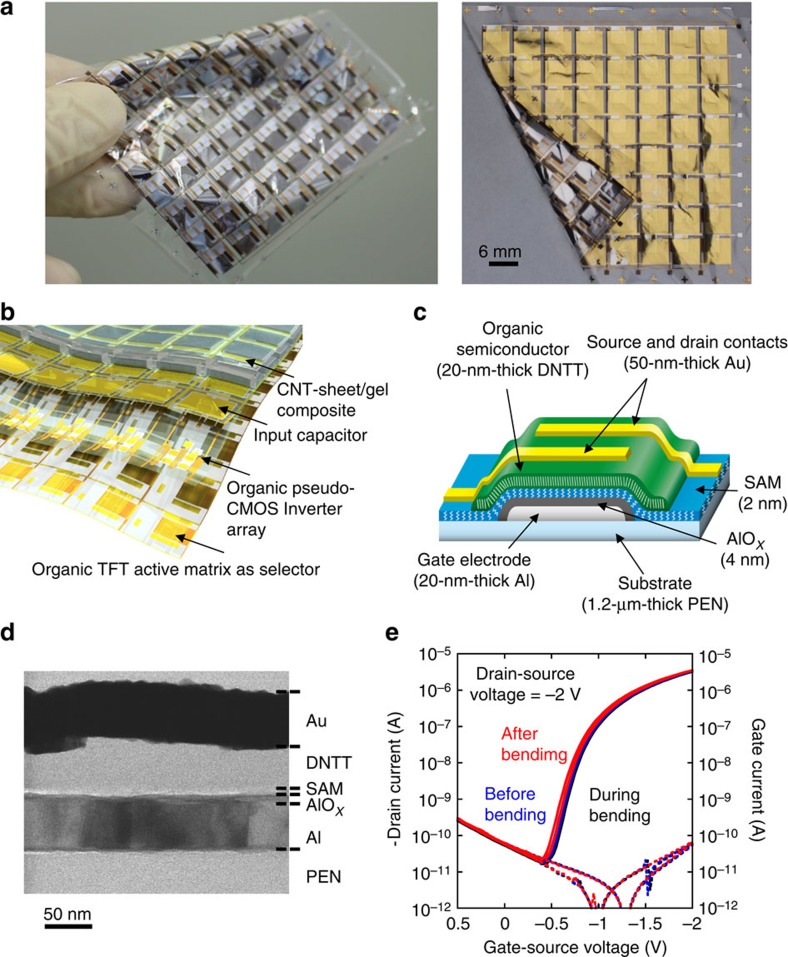
Ultraflexible organic integrated circuits.(a) Picture and (b) schematic illustration of the 1.2-μm-thick ultraflexible amplifier array comprising organic transistors. (c) Cross-sectional image and (d) high-resolution cross-sectional electron microscopy image of an organic transistor on a 1.2-μm-thick plastic substrate. (e) Electrical characteristics of an organic transistor before, during and after bending to a radius of 50 μm. The transistor is fabricated on a 1.2-μm-thick PEN substrate and 1.3-μm-thick parylene encapsulation stack. The transistor channel is located at the neutral strain position. The transistor characteristics confirm that the devices are not damaged when bent to a radius of 50 μm.